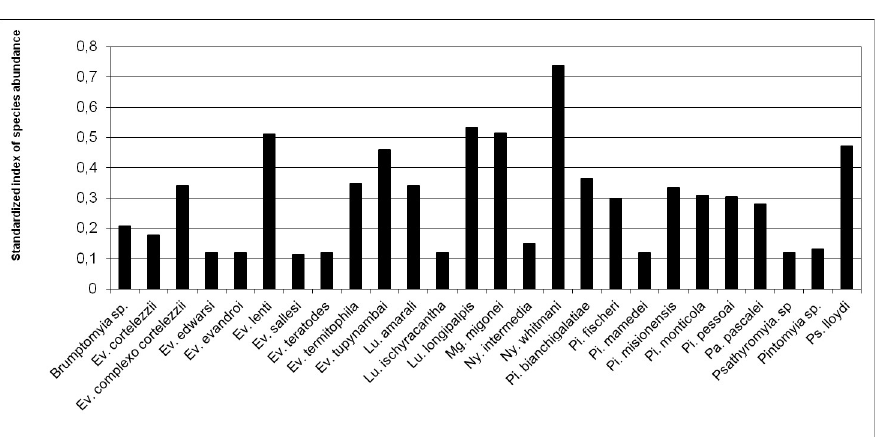
Fig 2. Standardized index of species abundance of species collected at Casa Branca, Brumadinho, Minas Gerais from May 2013 to July 2014.